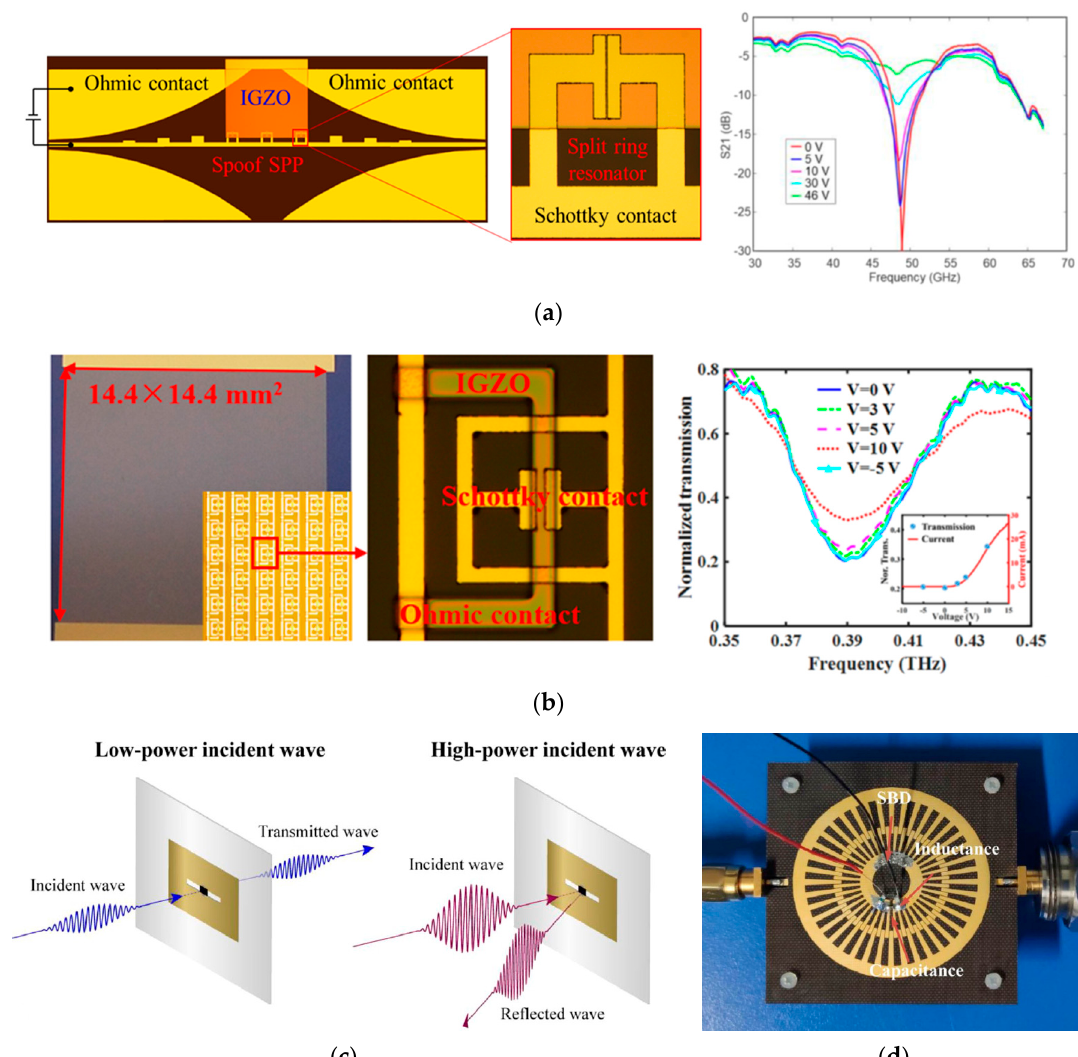
Figure 4. Active metasurfaces with Schottky junctions and diodes. Copyright American Chemical Society, 2019. ( a ) Amplitude modulation of surface plasmon polariton metamaterials with IGZO Schottky junctions [75]. ( b ) Active terahertz metamaterials with IGZO Schottky junction at 400 GHz [77]. ( c ) Power − level controlled metamaterial structures with Schottky diodes [78]. ( d ) Plasmonic metamaterials with Schottky diode switch [80].